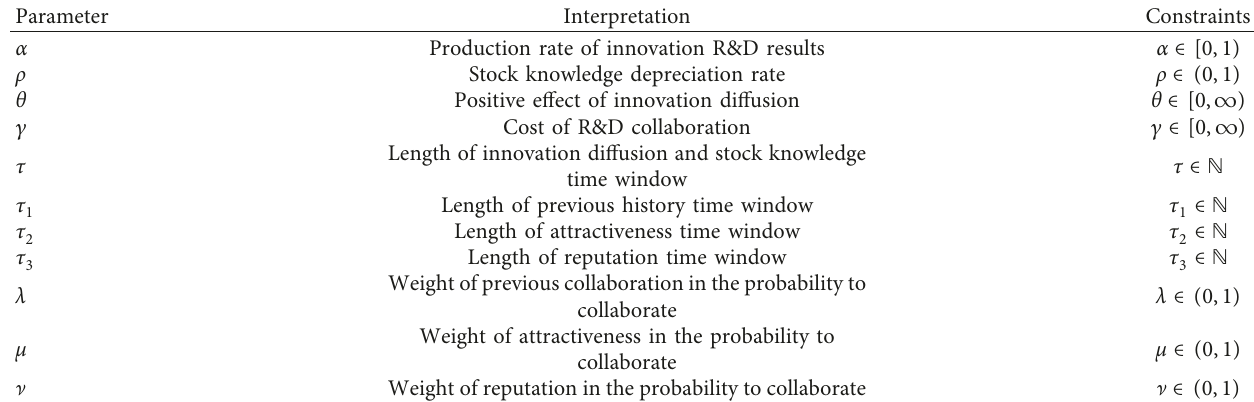
Table 1: Parameters used in the